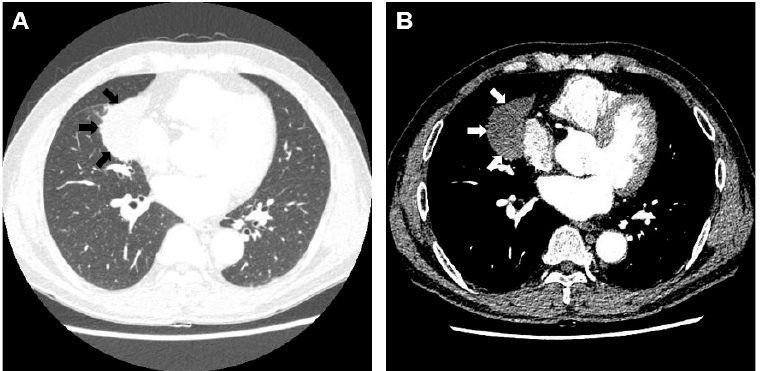
Figure 1. Initial Computed Tomography (CT) findings of a patient with lung cancer. ( A ) Chest CT revealed a mass-like consolidation (59 × 35 mm) in the right middle lobe (black arrow). ( B ) In the mediastinal window, a low-density area was visible in the target lesion, without cavity formation (white arrow). After the patient had been hospitalized, we used a 4.0 mm-diameter flexible bron-